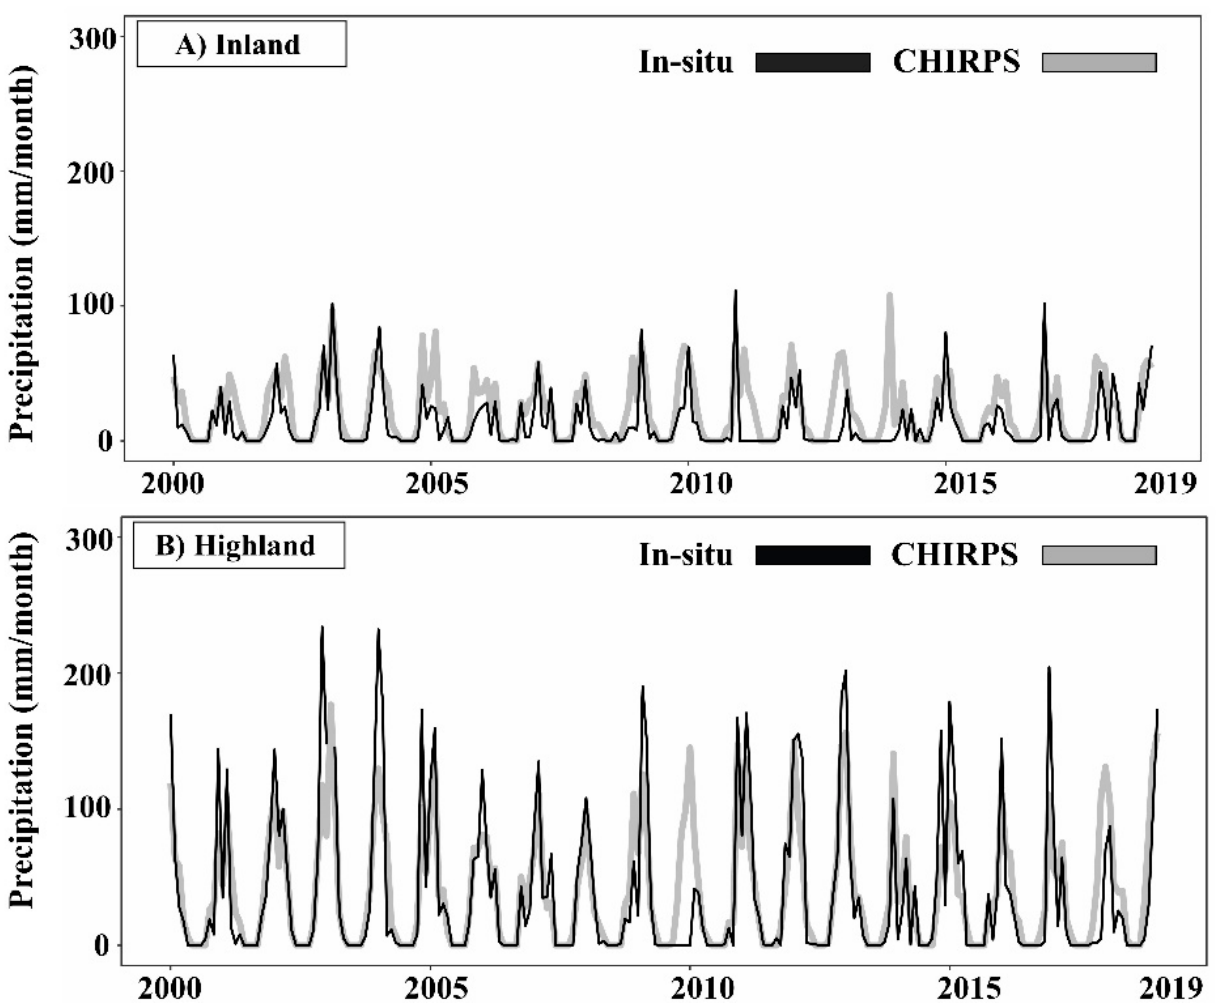
Figure 5. Monthly time series comparison between CHIRPS product precipitation estimates and in-situ precipitation measurements between 2000 and 2019, at ( A ) inland part and ( B ) highland part.